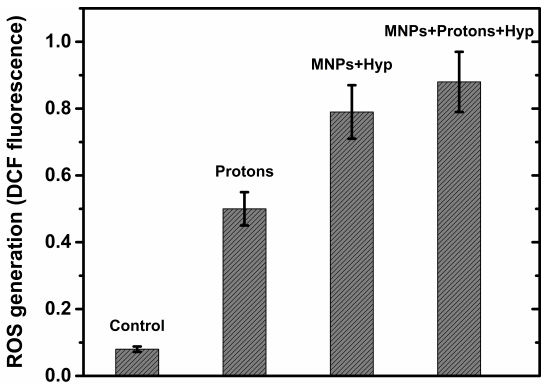
Figure 6. Flow cytometry analysis of BxPC3 cells to detect ROS induction after proton irradiation, MNPs and hyperthermia. Control: untreated cells; Protons: cells irradiated with 4 Gy of protons; MNPs+Hyp: cells with MNP-50 µ g/mL and hyperthermia treatment; MNPs+Protons+Hyp: cells with MNP-50 µ g/mL, irradiated with 4 Gy of protons and hyperthermia treatment. Mean ± SD (2 experiments).